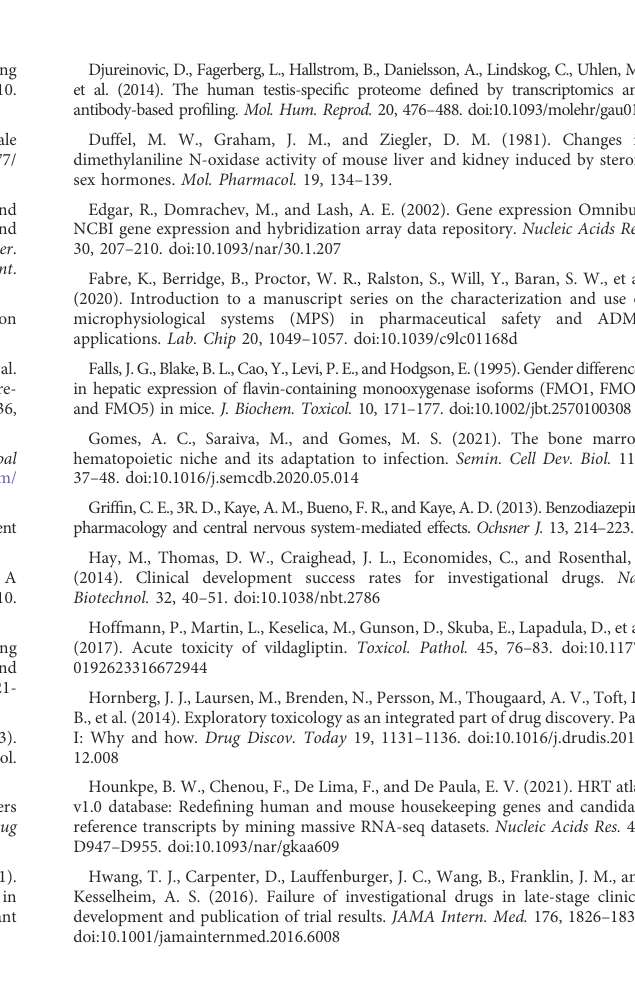
SUPPLEMENTARY FIGURE S5 Correlation Analysis Across Major Toxicity Organs. Spearman correlation analysis was performed to assess differences across duodenum, heart, kidney, liver, lung, and spleen in both males (A) and females (B) . SUPPLEMENTARY FIGURE S6 Hierarchical Clustering of Tissues in Mouse and Rat. Dendrogram to visualize hierarchical clustering of female tissues (left) in mouse (A) and rat (B) . These tissues were also mapped to broader organ/system classi fi cations (right). SUPPLEMENTARY FIGURE S7 Hierarchical Clustering of Tissues in Dog and Monkey. Dendrogram to visualize hierarchical clustering of female tissues (left) in dog (A) and monkey (B) . These tissues were also mapped to broader organ/system classi fi cations (right). SUPPLEMENTARY FIGURE S8 Expression heat map of key transporters in the liver, kidney, and heart of female preclinical species and humans con fi rms tissue speci fi c expression of liver and kidney transporters across species. Heart was included asageneralnegativecontrol asfewtransportersarereported to be highly expressed there. Expression patterns are generally consistent across species and across sexes with some notable